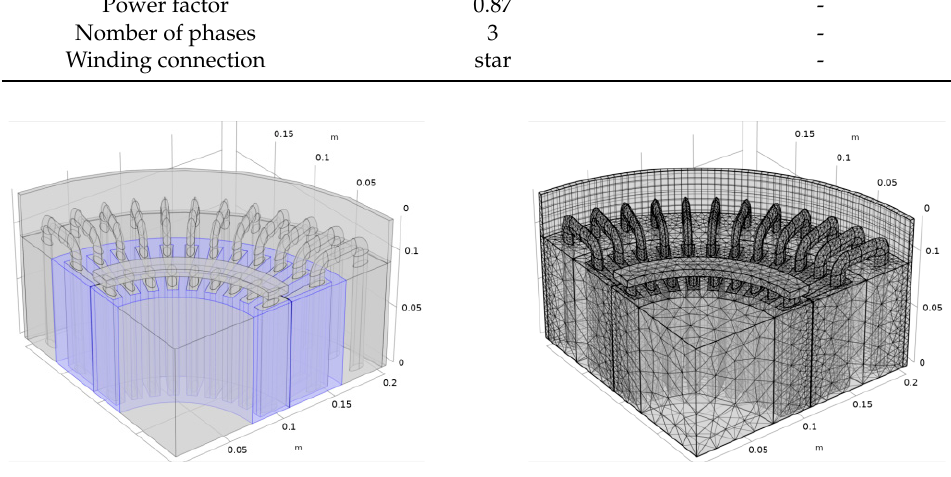
The number of rotor slots was reduced from 39 to 36 to simplify the model and in- crease the convergence of calculations. The stator winding in each slot is represented by a separate homogeneous multiturn coil. The other end of this coil closes outside the stator. The rotor winding is represented by a solid copper conductor, which is a squirrel cage. The geometry of the SCIM model of the investigated motor and the mesh are shown in Figure 2a and Figure 2b.